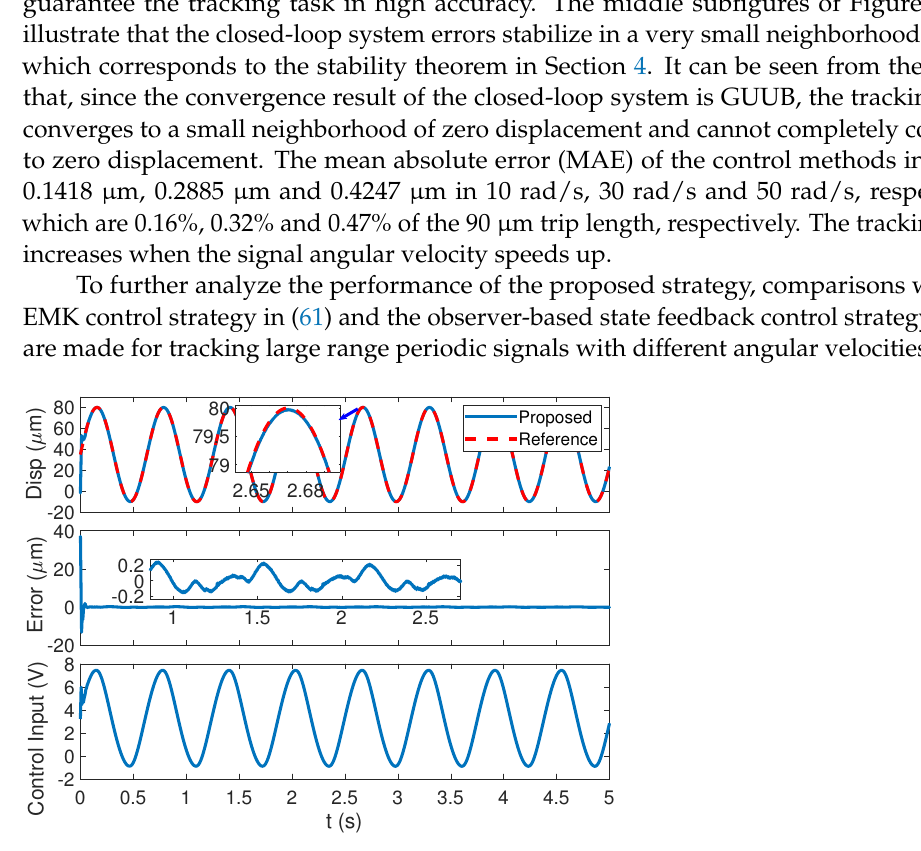
Figure 10. Experimental results of the sinusoid signal via the proposed algorithm (10